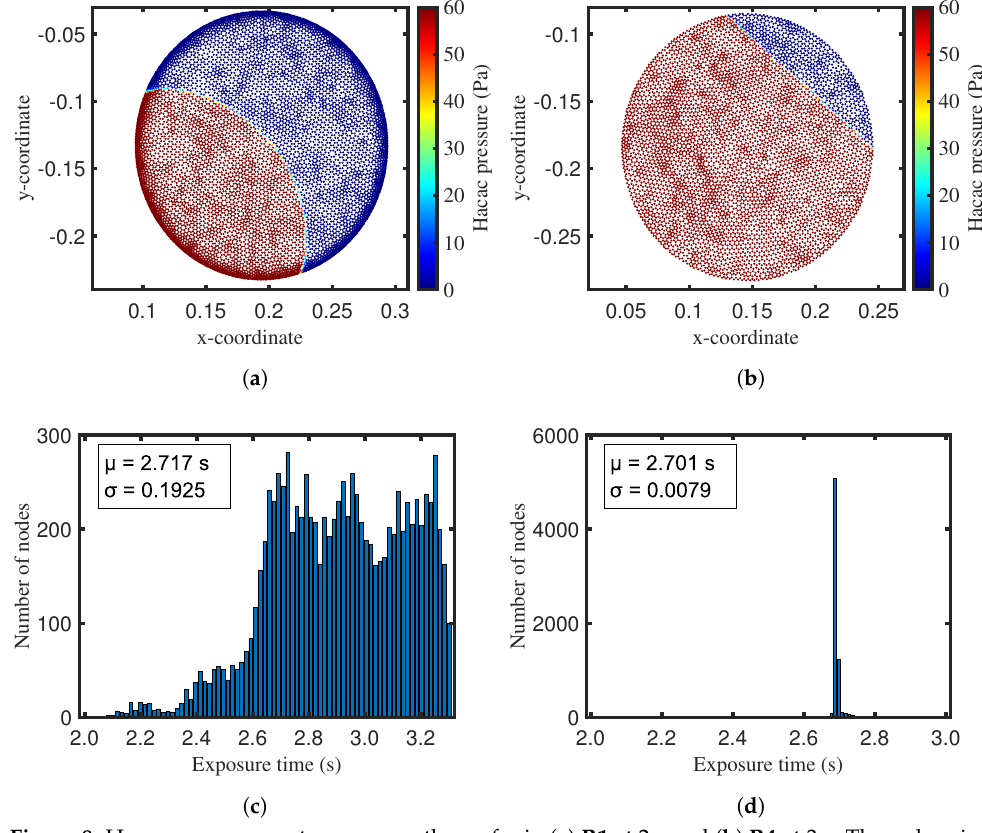
Figure 8. Hacac pressure contours across the wafer in ( a ) R1 at 2 s and ( b ) R4 at 3 s. The red region in ( a , b ) indicates the area that is covered with the reagent, Hacac. Distribution of exposure time for all nodes in the wafer for ( c ) R1 and ( d ) R4 . µ and σ represent the average and standard deviation, respectively. There are 10,410 nodes in R1 and 6737 nodes in R4